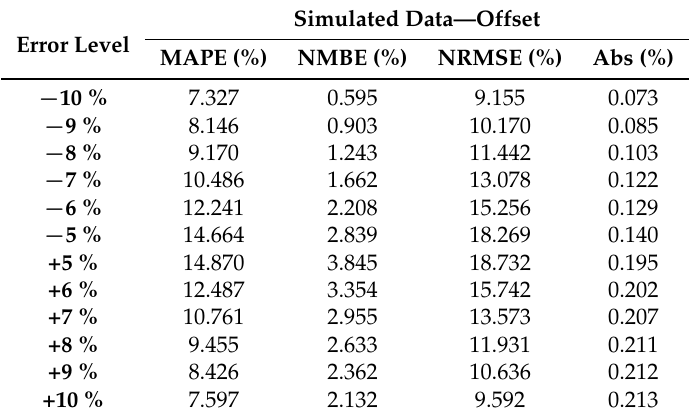
Table 2. Error indicators for different offset error levels—Simulated data.